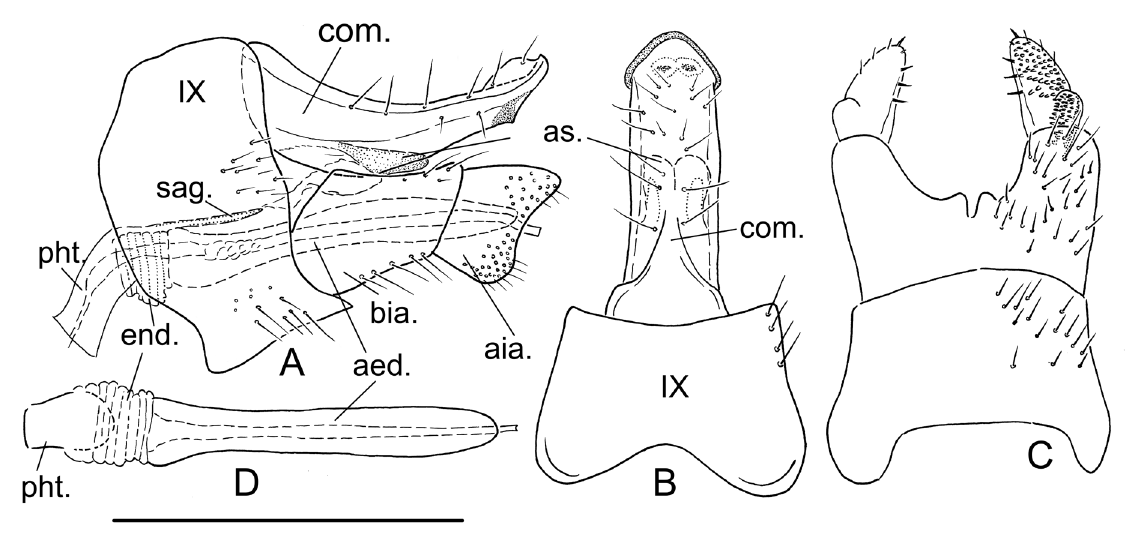
Fig. 2. Rhyacophila voluta sp. nov., male genitalia. A . Lateral view. B . Dorsal view. C . Segment IX and inferior appendages, ventral view. D . Phallic apparatus, ventral view. Scale bar: 0.5